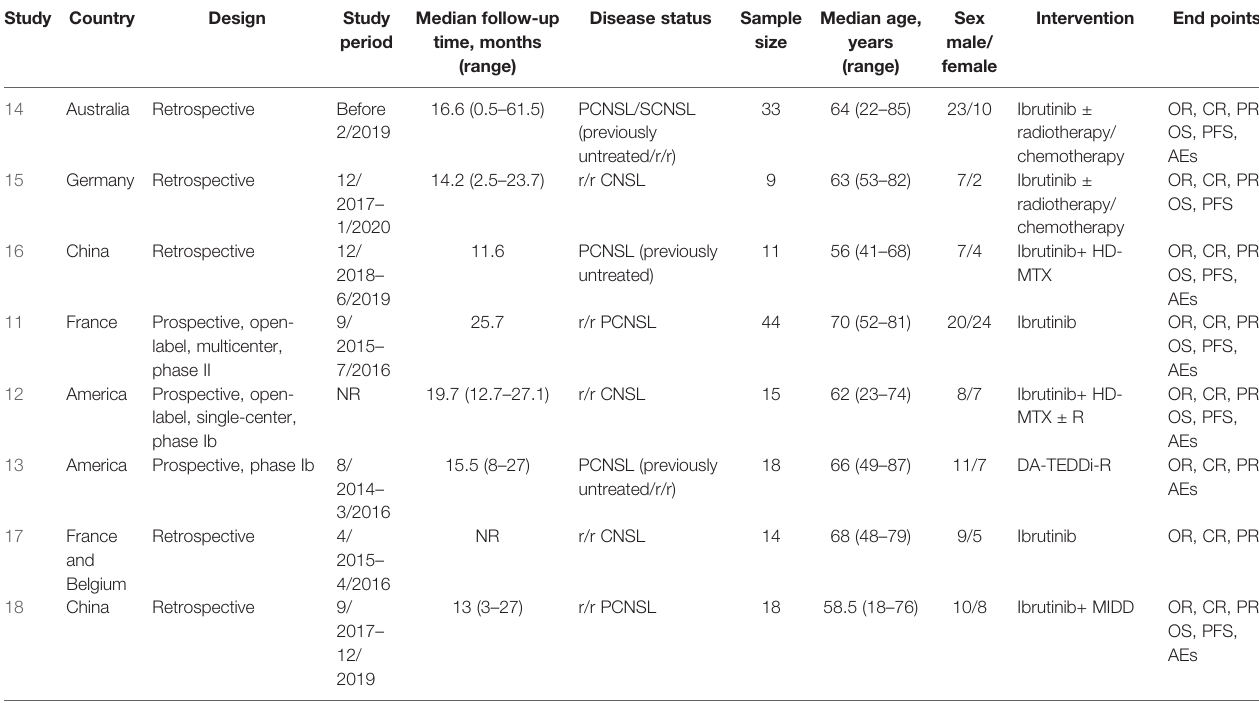
TABLE 1 | Baseline clinical characteristics of included